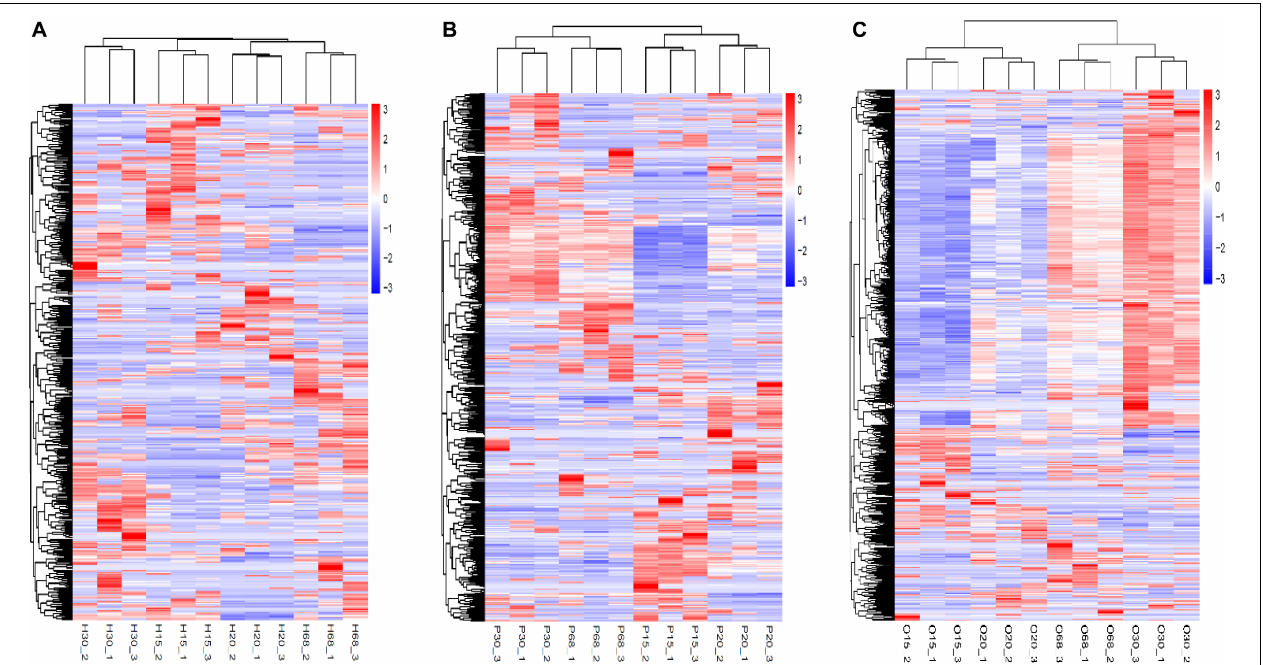
FIGURE 3 | Hierarchical clustering heatmap of DEGs in the three tissues of HPO axis at four ages [ (A) hypothalamus, (B) pituitary, and (C) ovary]. The horizontal axis below showed sample name, while the horizontal axis above showed sample clustering, the left vertical axis represented gene clustering. The color from red to blue indicates gene expression from high to low.